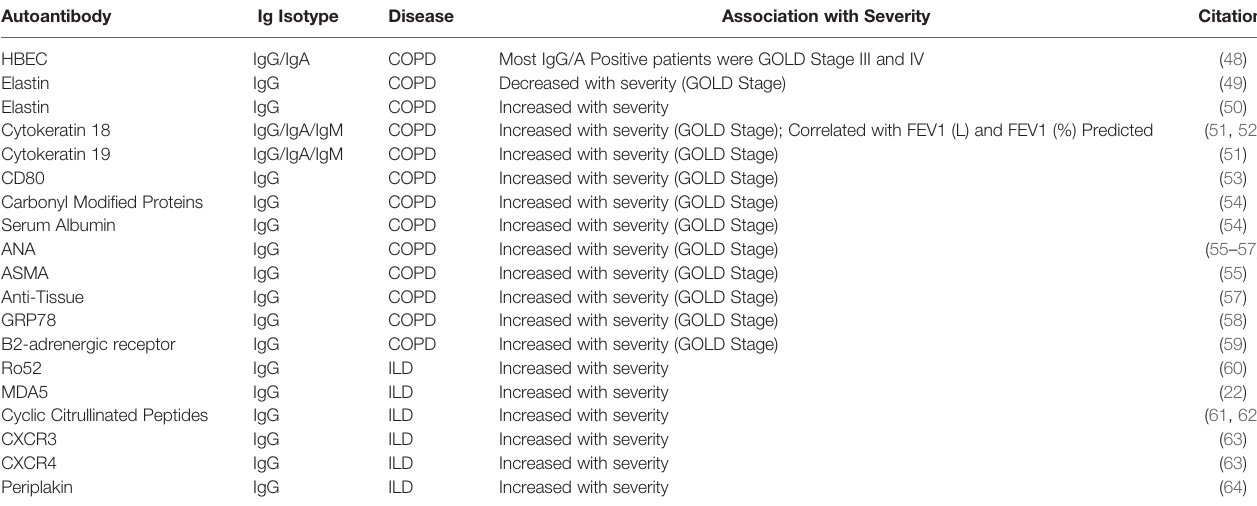
TABLE 1 | Autoantibody titers correlate with disease progression.